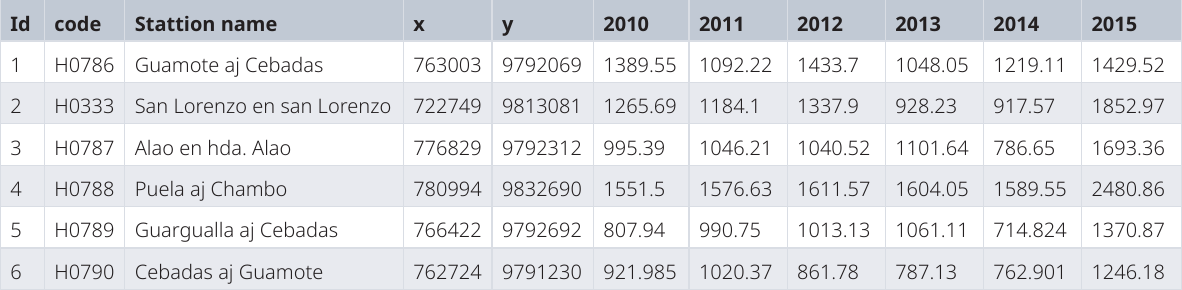
Table 1. Precipitation values provided by meteorological stations between 2010 and 2015. Id